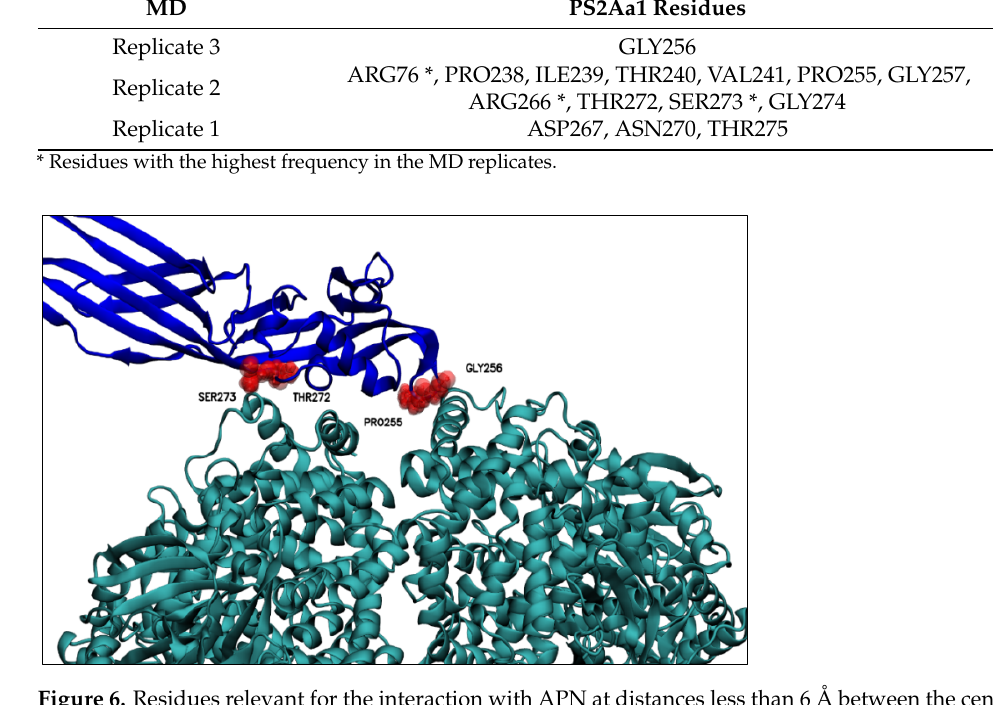
Table 6. Distances of the residues of PS2Aa1 relevant to interacting with